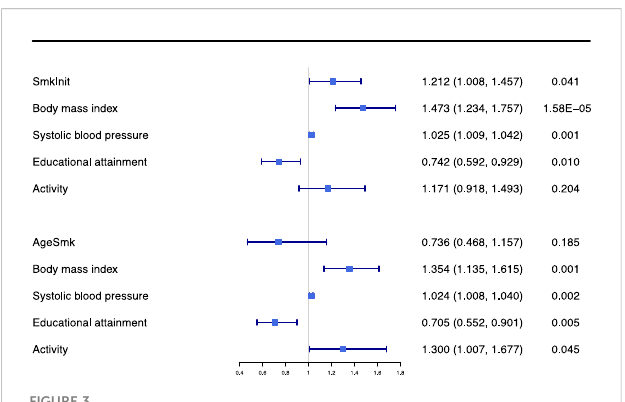
FIGURE 3 Multivariable Mendelian randomization results for association of smoking initiation and age at initiation of regular smoking with coronary artery disease in patients with diabetes when adjusted for body mass index, systolic blood pressure, educational attainment and activity. MVMR, multivariable Mendelian randomization; SmkInit, smoking initiation; AgeSmk, age at initiation of regular smoking.